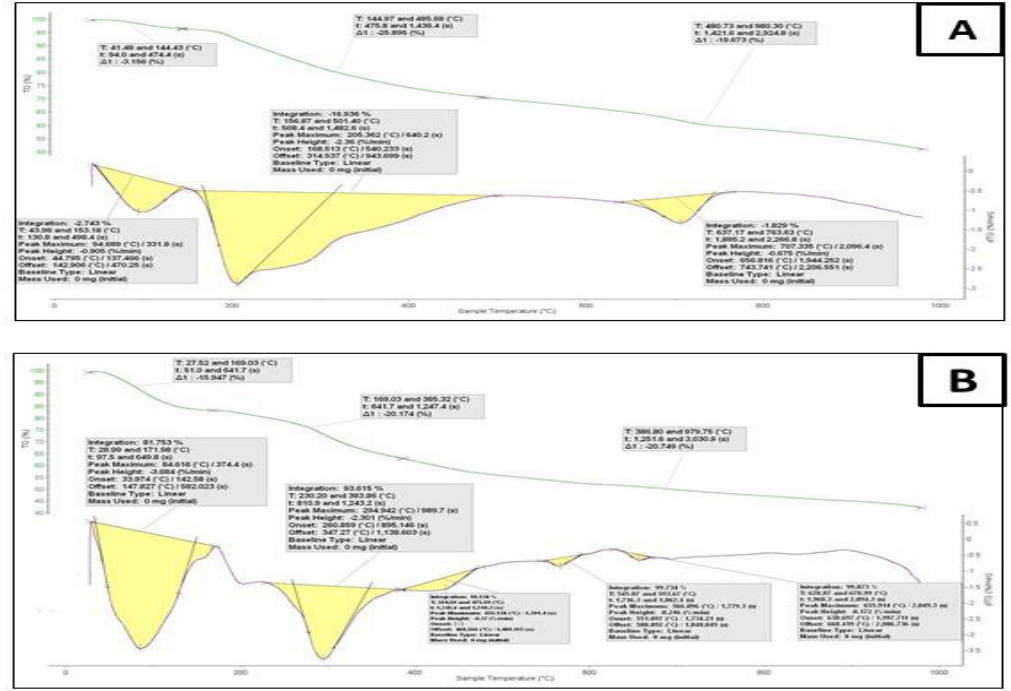
Figure 4. Thermogravimetric analysis of ( A ) cefotax/Ca and ( B )